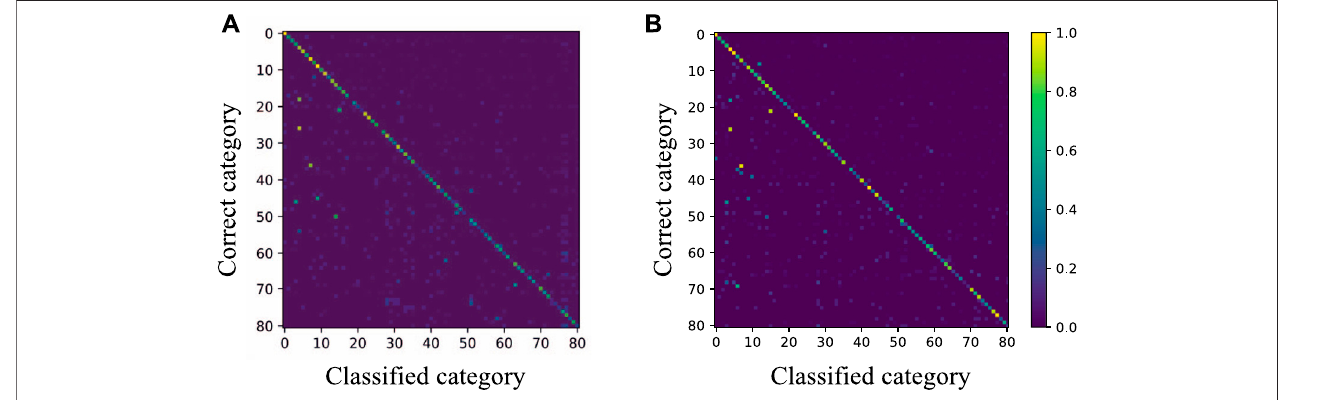
FIGURE 10 | Classi fi cation results (normalized confusion matrices): (A) MNVAE + MLDA and (B) MLDA.